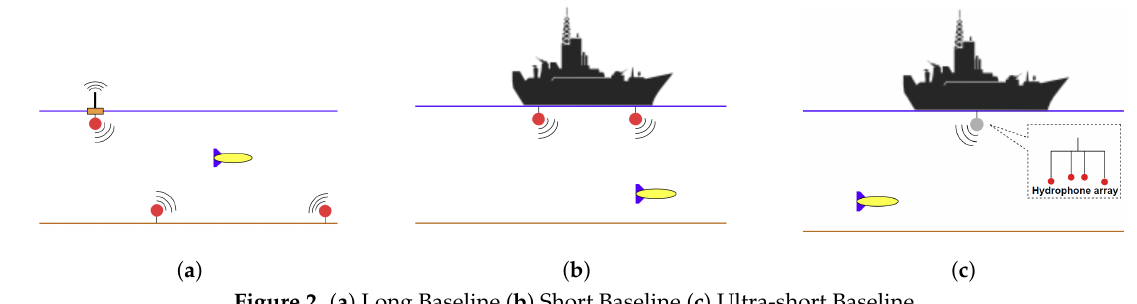
Figure 2. ( a ) Long Baseline ( b ) Short Baseline ( c ) Ultra-short